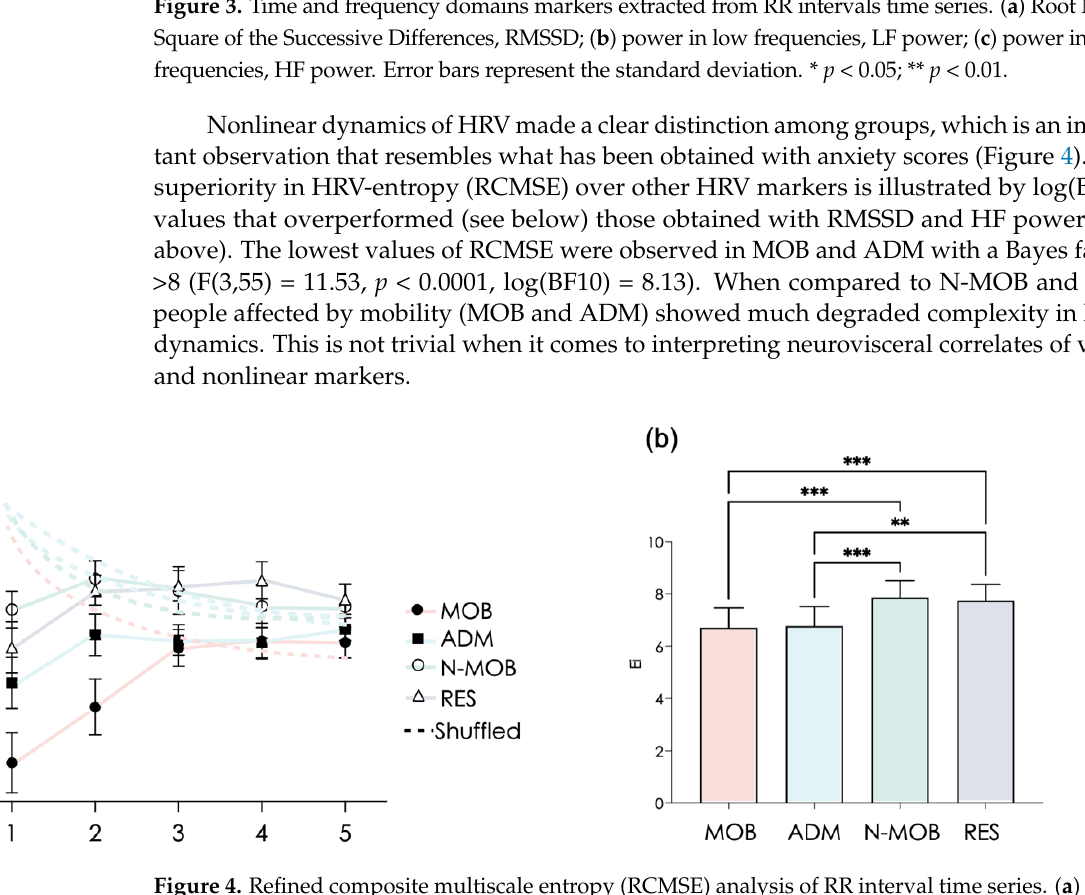
Figure 4. Refined composite multiscale entropy (RCMSE) analysis of RR interval time series. ( a ) Sample entropy values at time scales 1 to 5 are reported for each group (MOB, ADM, N-MOB, RES) (mean ± SD). The RCMSE curves for the surrogate shuffled time series are also presented (dotted lines). The entropy index represents the trapezoid approximation of the area under each curve; ( b ) mean values of the entropy index (Ei, arbitrary unit). * p < 0.05; ** p < 0.01;*** p < 0.001